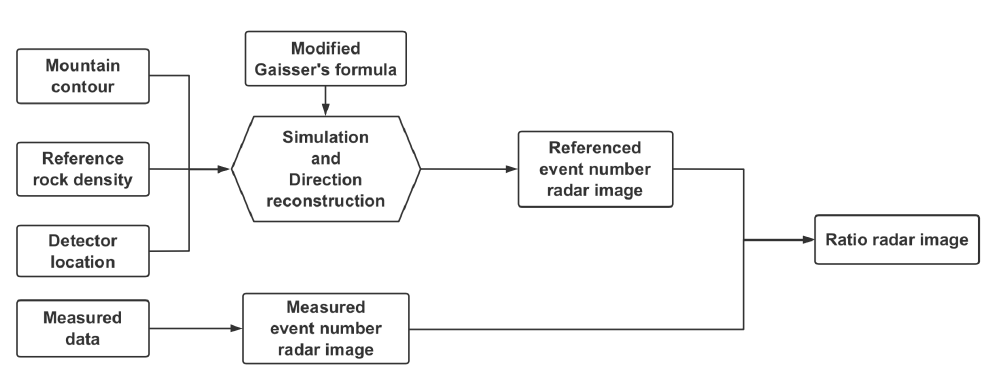
Figure 4. Analysis flow chart of the mountain MT.